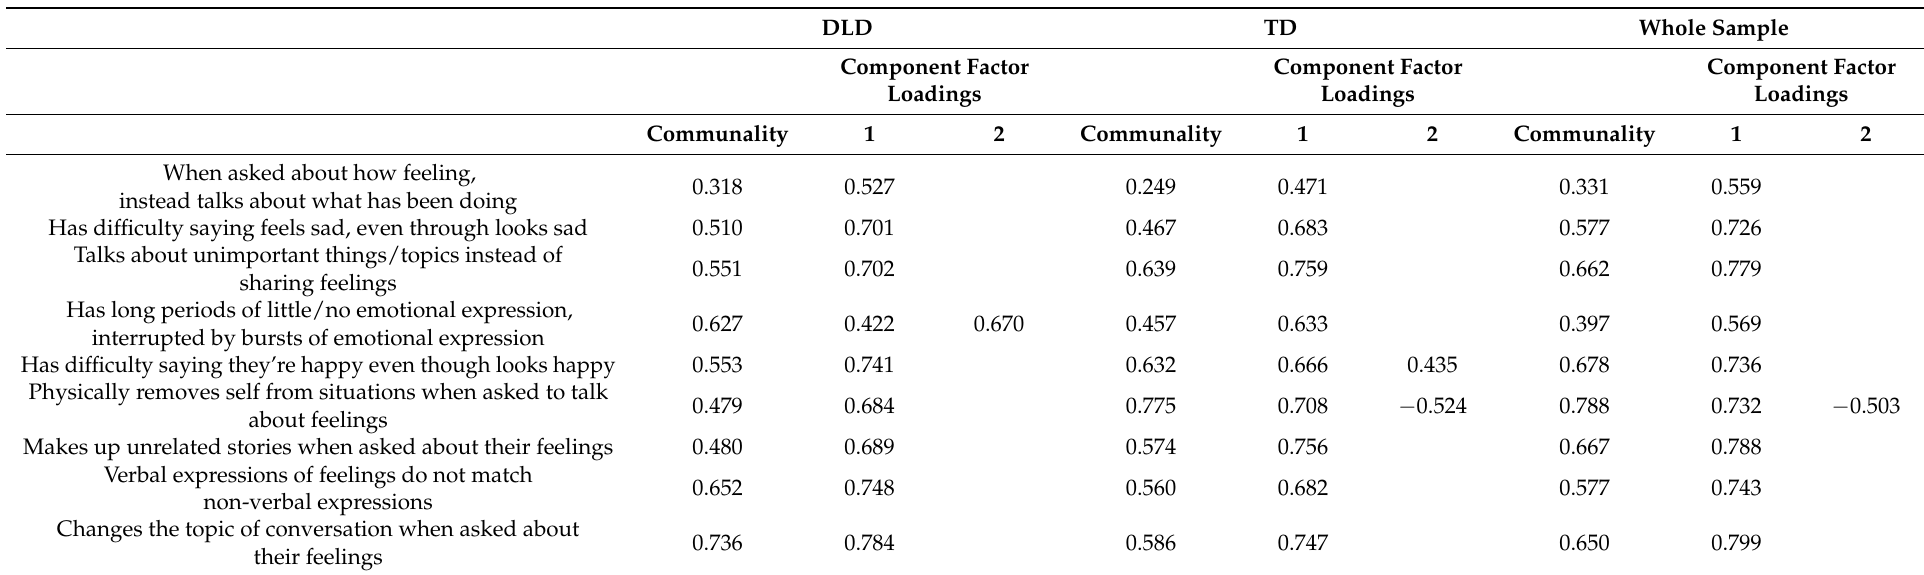
Table 5. Communalities and factor loadings for CAM